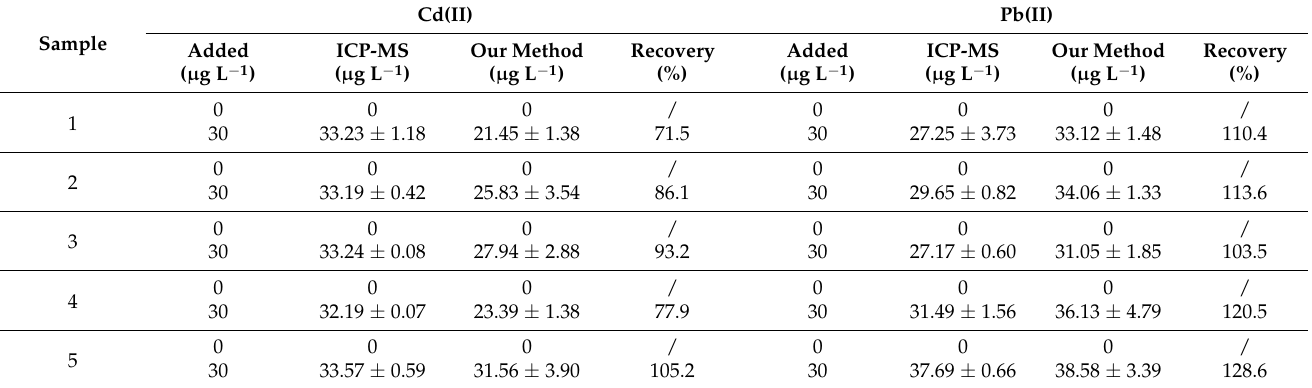
Table 1. Recovery measurement for HMI detection in the extracted infant milk powder.